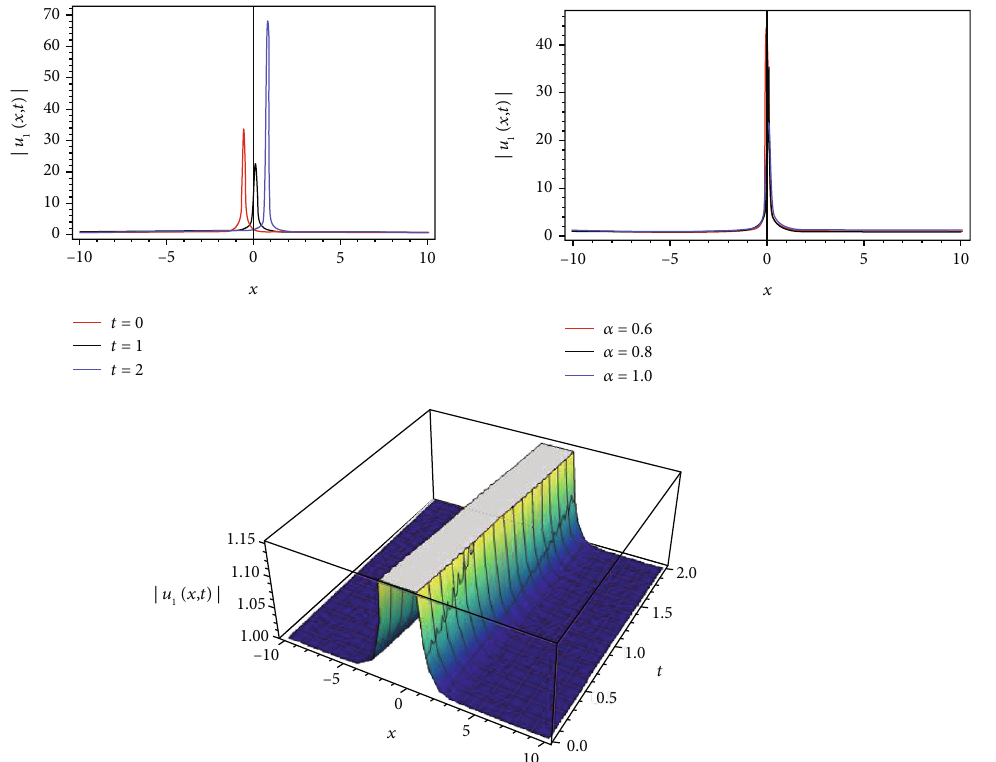
Figure 7: 2D and 3D graphics of Case 1 for hyperbolic traveling wave solution (47) at f α = 0 : 6, k = 0 : 7, q = 1, s = 1, C = − 1, c = 0 : 5 g